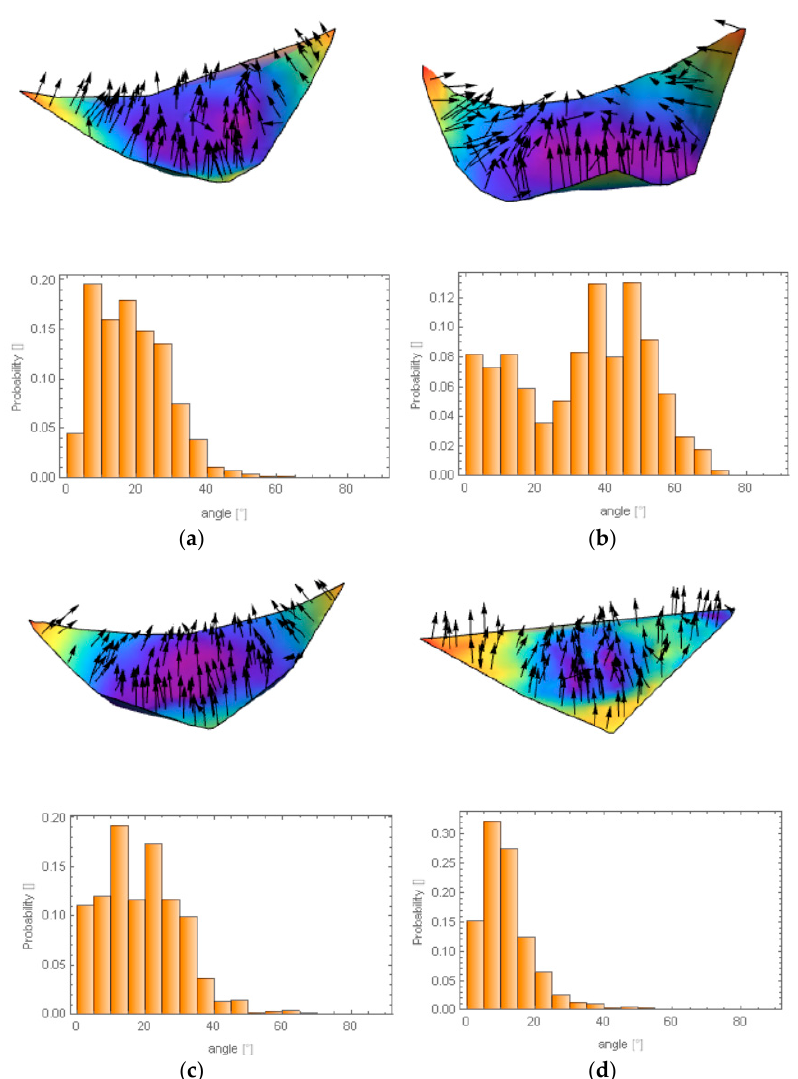
Figure 8. The configurations 1 ( a ) and 3 ( c ) have shown similar normal distributions with the main peak at about 10 ◦ . In configuration 2 ( b ), a partial deployment has occurred, half of the distribution with an angle of more than 36 ◦ . The best result has been obtained for Configuration 4 ( d ): the 80% of the normal distributions have shown an inclination less than 16 ◦ with a median at 10.5 ◦